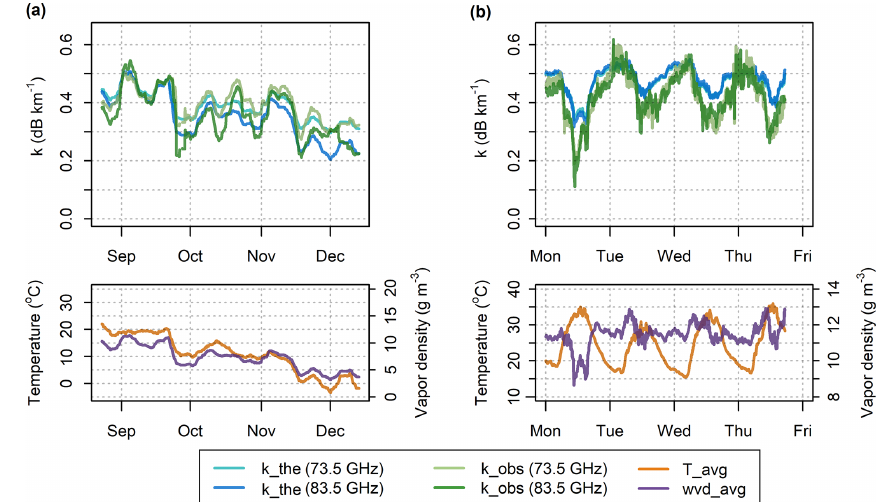
Figure 7. Theoretical and observed specific attenuation from the 73.5 and 83.5GHz sublinks of CML 1 and observed temperature and water vapor density – (a) data over the whole observation period smoothed by a moving average with 1-week window and (b) 5min data during four summer